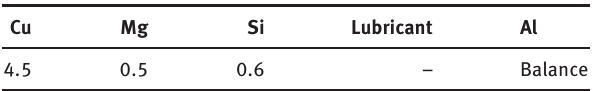
Table 1: Chemical composition of Al alloy Alumix 123 powder (weight%).